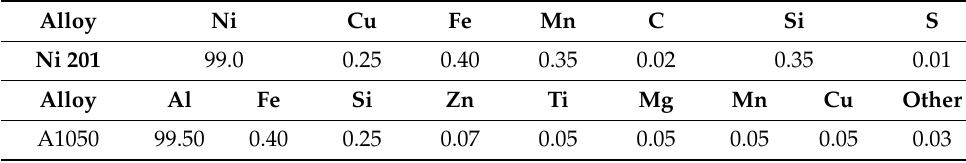
Table 1. Chemical compositions of the initial